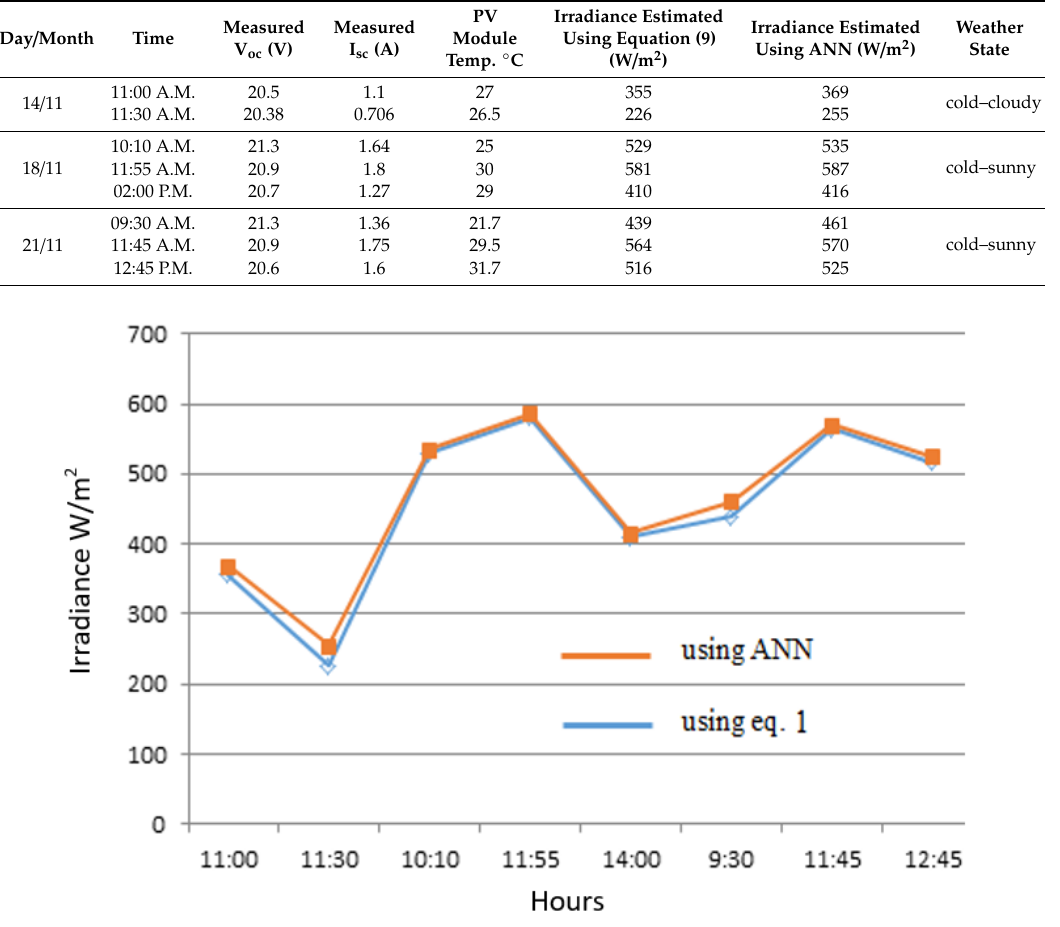
Figure 9. Comparison between irradiance estimates based on NN and Equation (1).